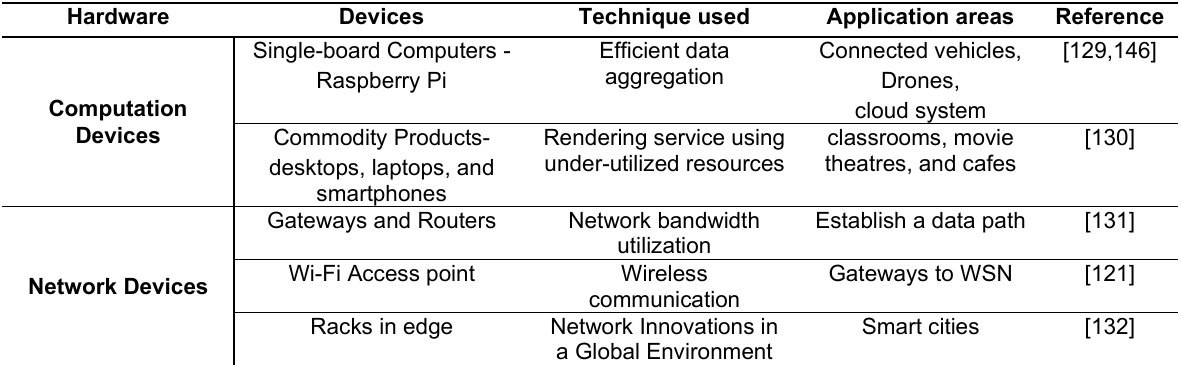
Table 3. Hardware for IoT Infrastructure